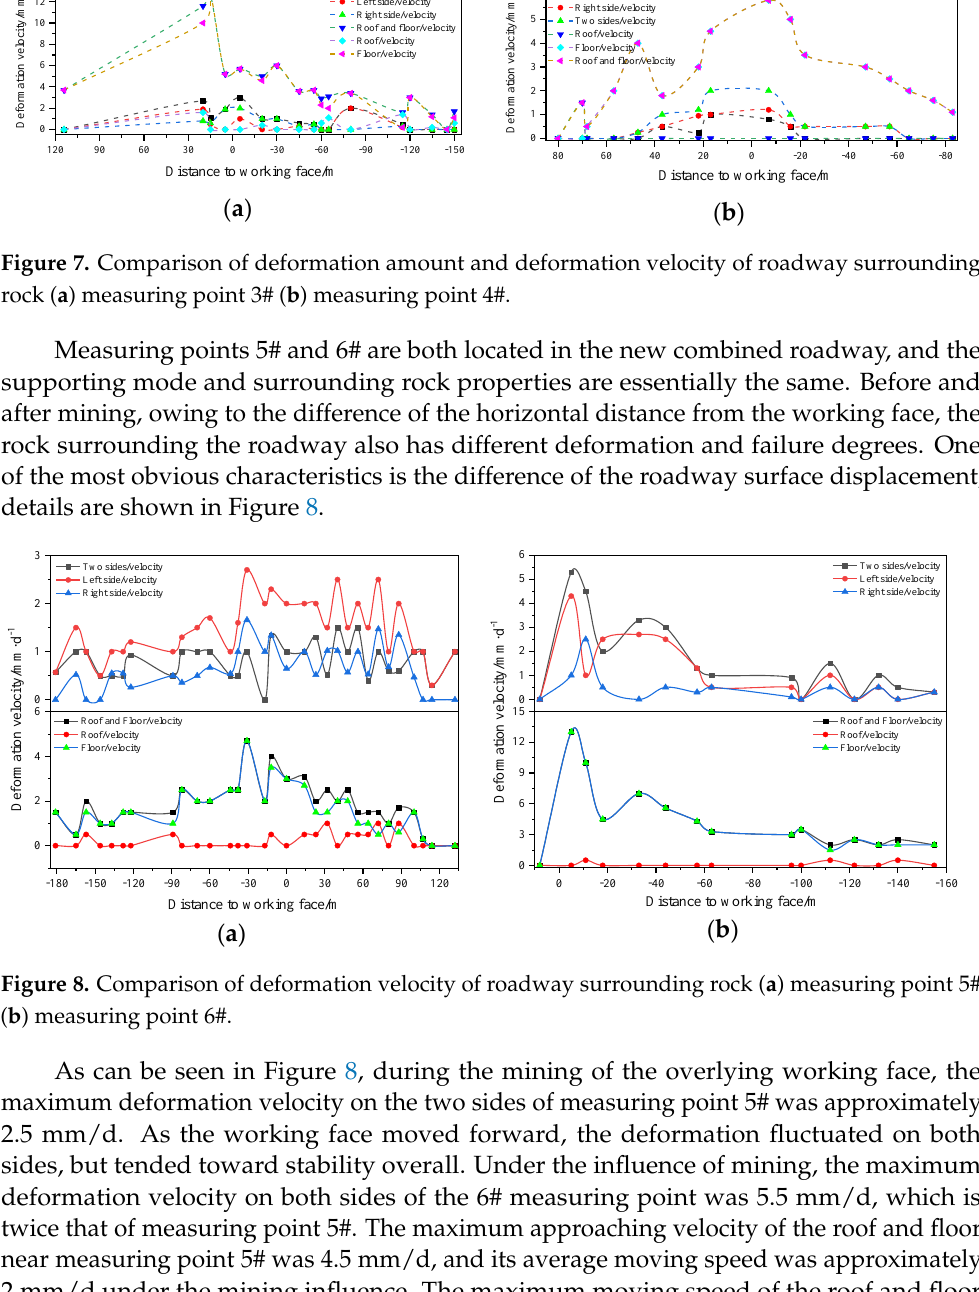
Two sides/velocity Left side/velocity Right side/velocity